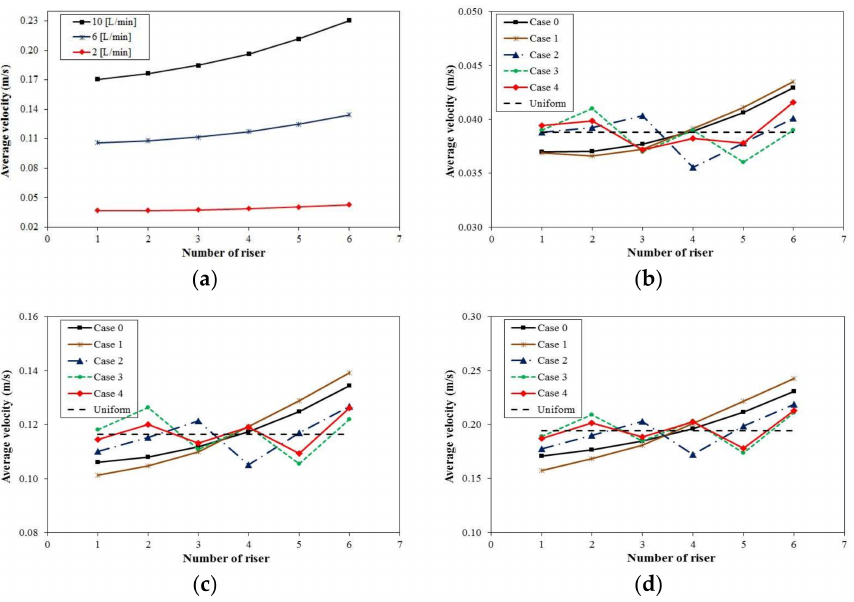
Figure 9. Average velocity in riser tubes at different volumetric flow rates: ( a ) Case 0 at 2, 6 and 10 L/min; ( b ) All cases at 2 L/min; ( c ) All cases at 6 L/min; ( d ) All cases at 10